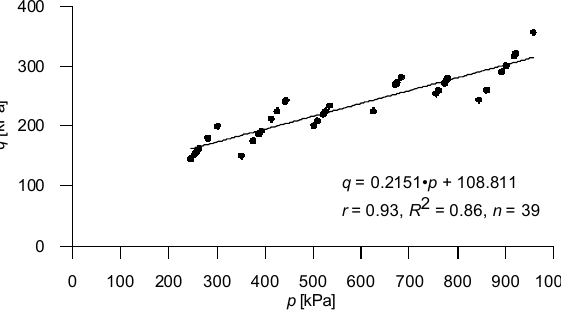
Figure 19: Result of strength tests for soil B-4.